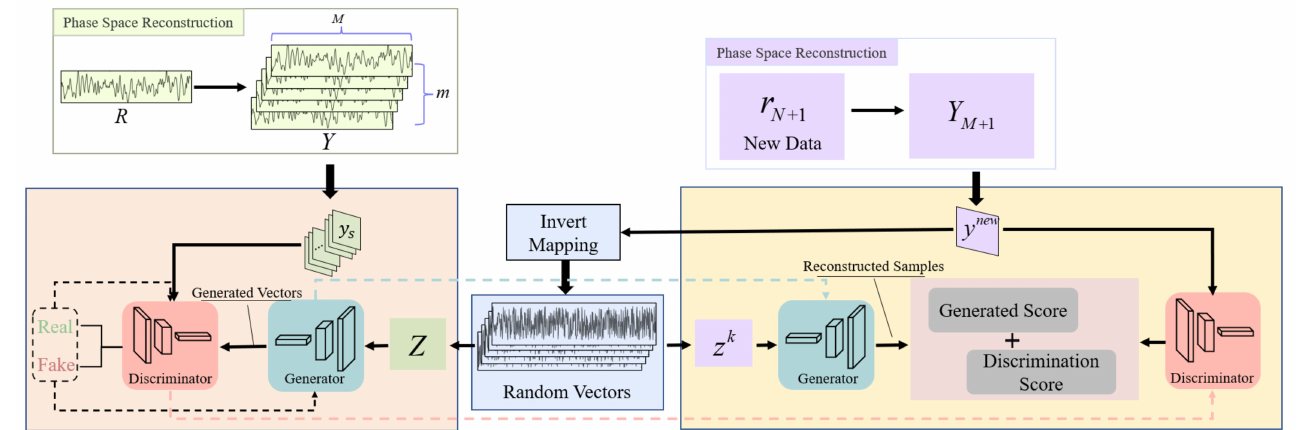
Figure 4. Model training and fault detection score generation. On the left is shown the training process of the model, and on the right is the process of calculating the fault detection